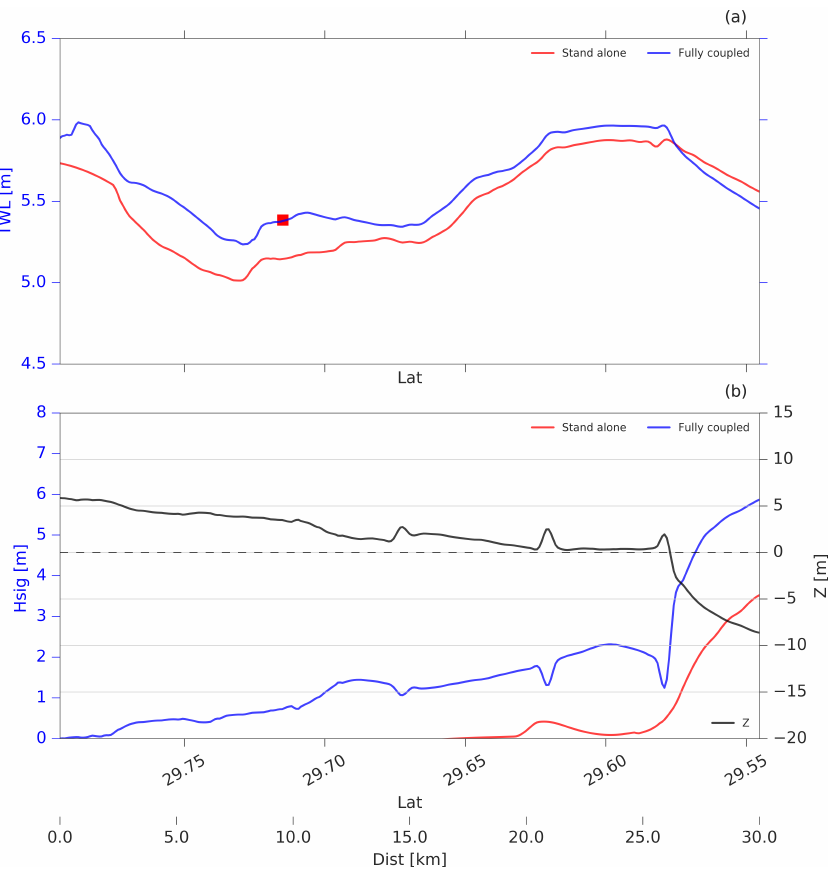
Figure 5. Comparison of the results for the transect (blue line in Figure 6 of the total water level ( a ) and wave height ( b ) for Fully coupled and Stand alone cases are presented. The bold black line represents topobathy level referenced to the mean sea level (MSL). Red square shows the only available USGS High Water Mark observation in the 1 [km] radius from the transect (Black circle in Figure 6). All model configurations and results are pre-decisional and for official use only.